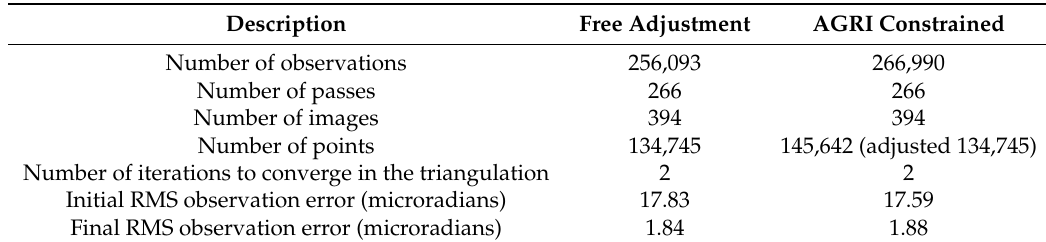
Table 3. Summary statistics on the number of observations, ground control points, images, and passes used in the triangulation solution for the Australia